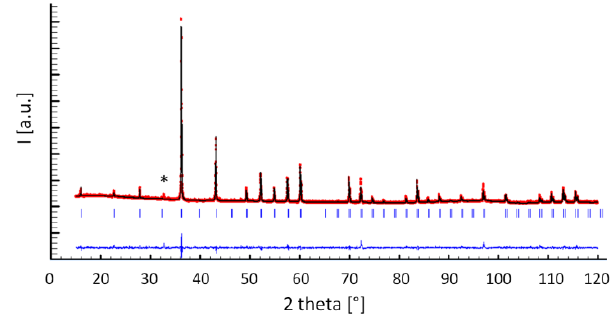
Figure 2. The Rietveld refinement plot of the sample Fe63_bulk. The red and black lines are the experimental and the calculated diffractogram, respectively; the lower line is the difference curve; the blue vertical bars indicate the calculated positions of Bragg peaks of the filled skutterudite; the asterisk (*) indicates the position of the main peak of Sb.